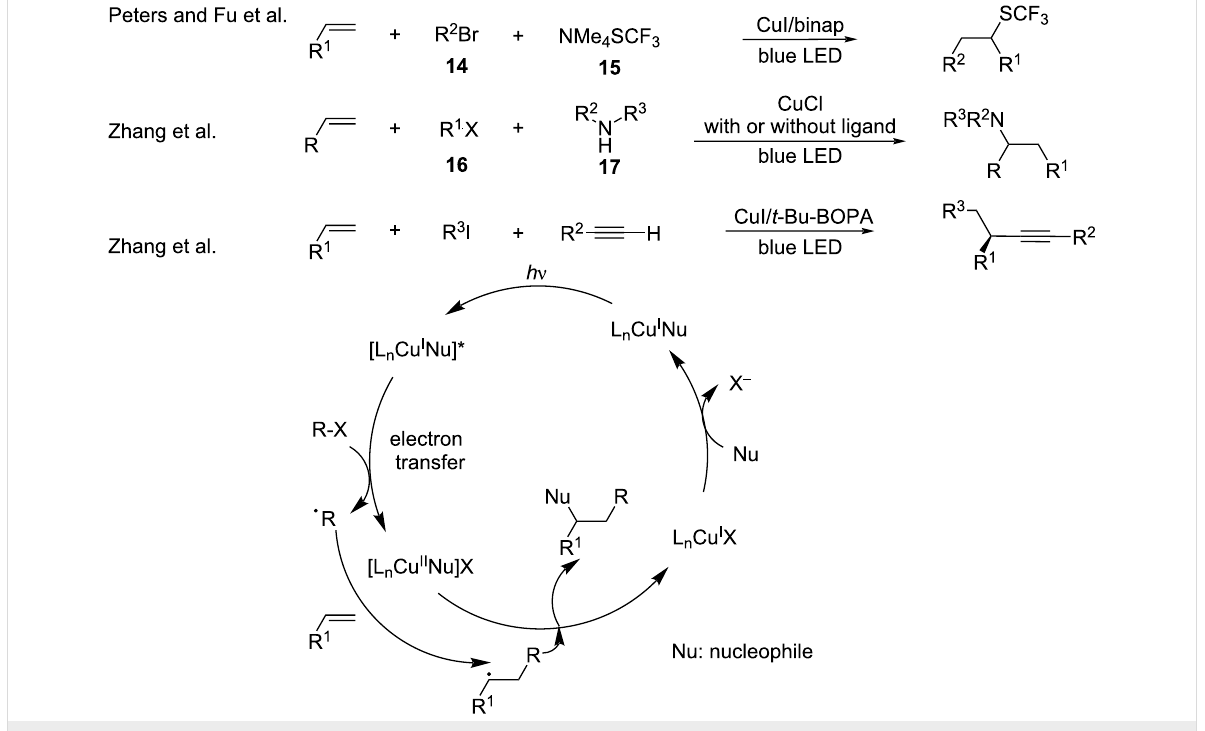
Scheme 11: Cross-coupling reaction of alkenes, alkyl halides with nucleophiles.